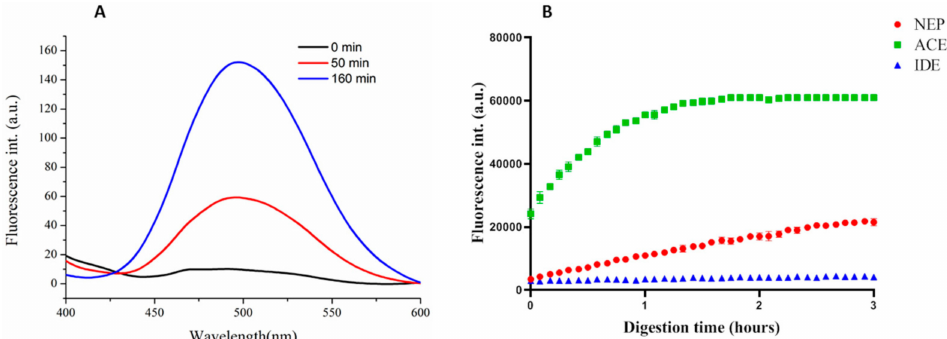
Figure 3. ( A ) The fluorescence spectra of qf-A β (12–16)AAC-EDANS digested by 2 nM NEP. qf-A β (12–16)AAC-EDANS (4 ◦ C. The fluorescence spectra were µ M) was digested by 2 nM NEP in 50 mM Tris, 25 mM NaCl, 5 µ M ZnCl 2 , pH 7.5 at 37 recorded at the indicated times with excitation wavelength of 336 nm on spectrofluorometer FP-750 (Jasco). ( B ) Degradation kinetics of qf-A β (12–16)AAC-EDANS by NEP, ACE, or IDE. qf-A β (12–16)AAC-EDANS (4 µ M) was digested by 2 nM NEP, ACE, or IDE in the assay buffer (5.5 mM D-glucose, 0.3 mM sodium pyruvate, 25 mM sodium bicarbonate, 1.5 µ M Zinc sulfate) incubated in a 96-well plate at room temperature. The fluorescence intensity at 500 nm was recorded on Infinite M1000 pro (Tecan) every 5 min with excitation at 355 nm. The data are averaged from triplicate samples. The error bar is too small to be